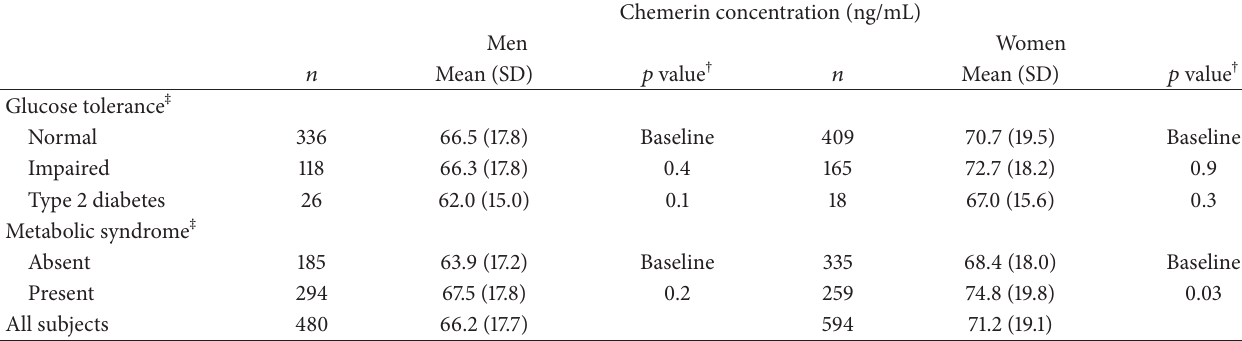
Table 3: Chemerin concentration according to glucose tolerance or metabolic syndrome in men and